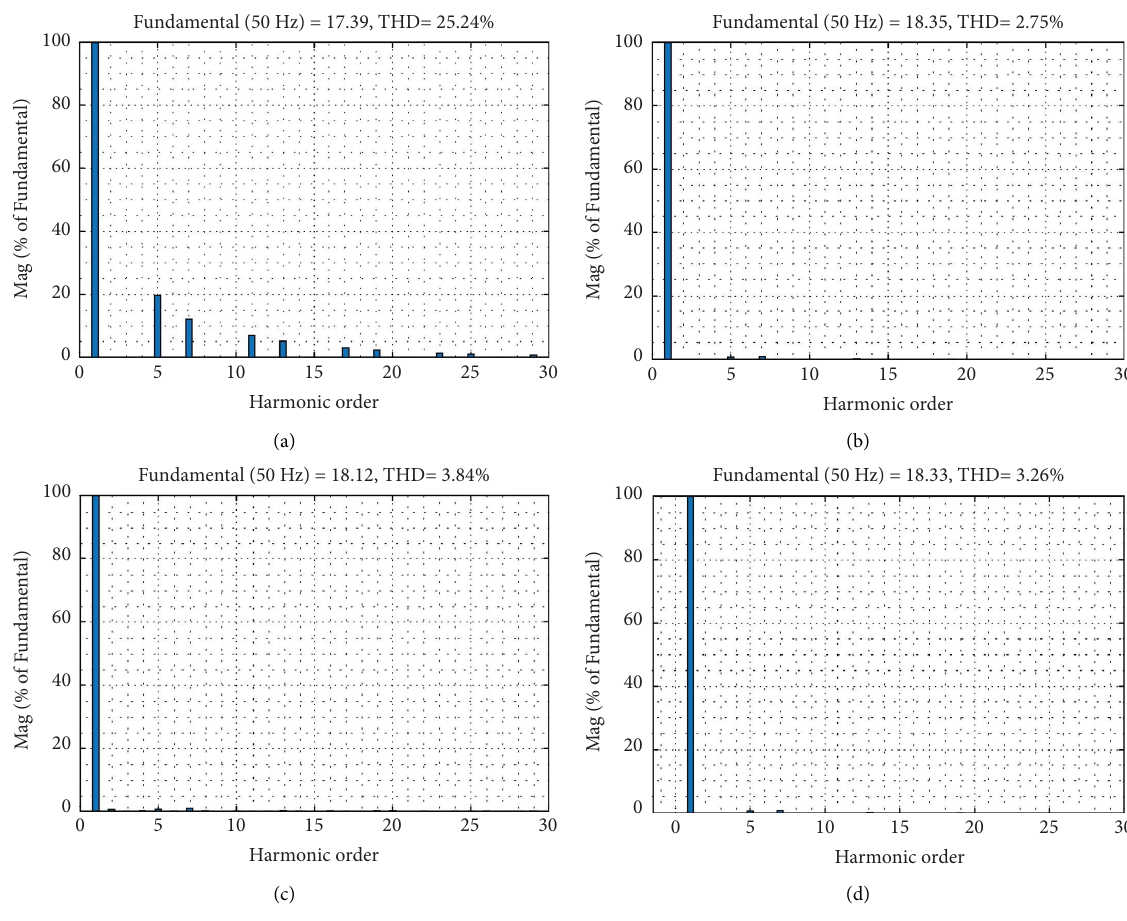
Figure 7: Spectral analysis of the grid current: (a) before compensation, (b) after compensation using the propose DTSC-ACO, (c) after compensation using hysteresis controller, and (d) after compensation using SMC.